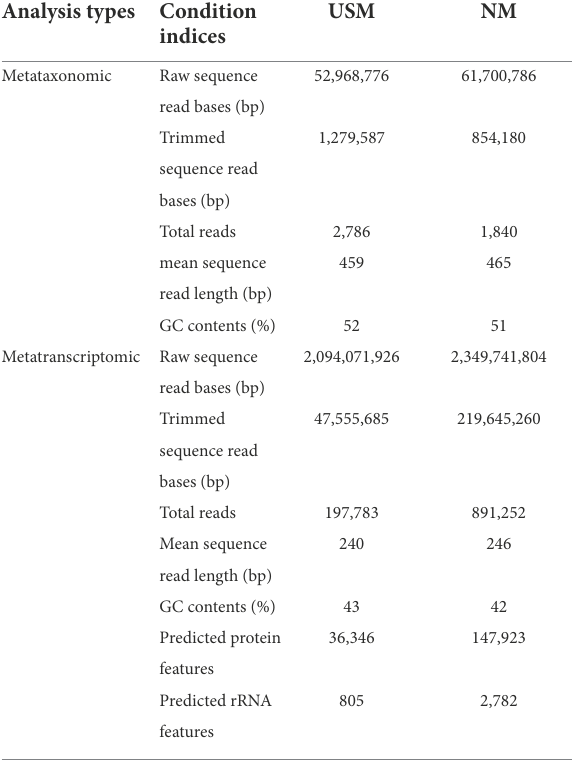
TABLE 1 Conditions of sequence reads for each sample by metataxonomic and metatranscriptomic analyses. Analysis types Condition